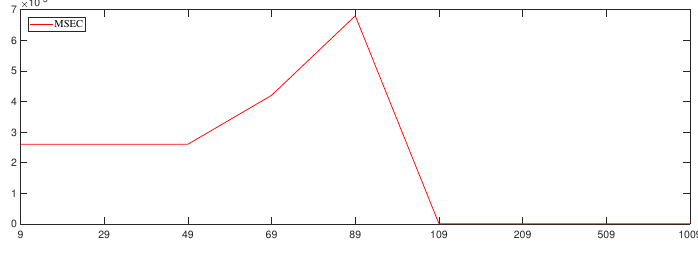
Figure 2. Folding line plot of the mean square error for a variance of 1.